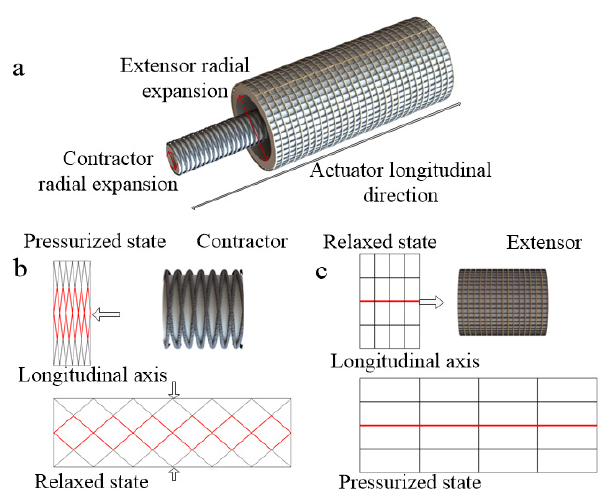
Figure 3. Mathematical model analysis. ( a ) Simplified model diagram of actuator. ( b ) The movement of the woven fabric when the extensor pressurized firstly and contractor is pressurized lately. ( c ) The movement of the elastic fabric when the extensor is pressurized.